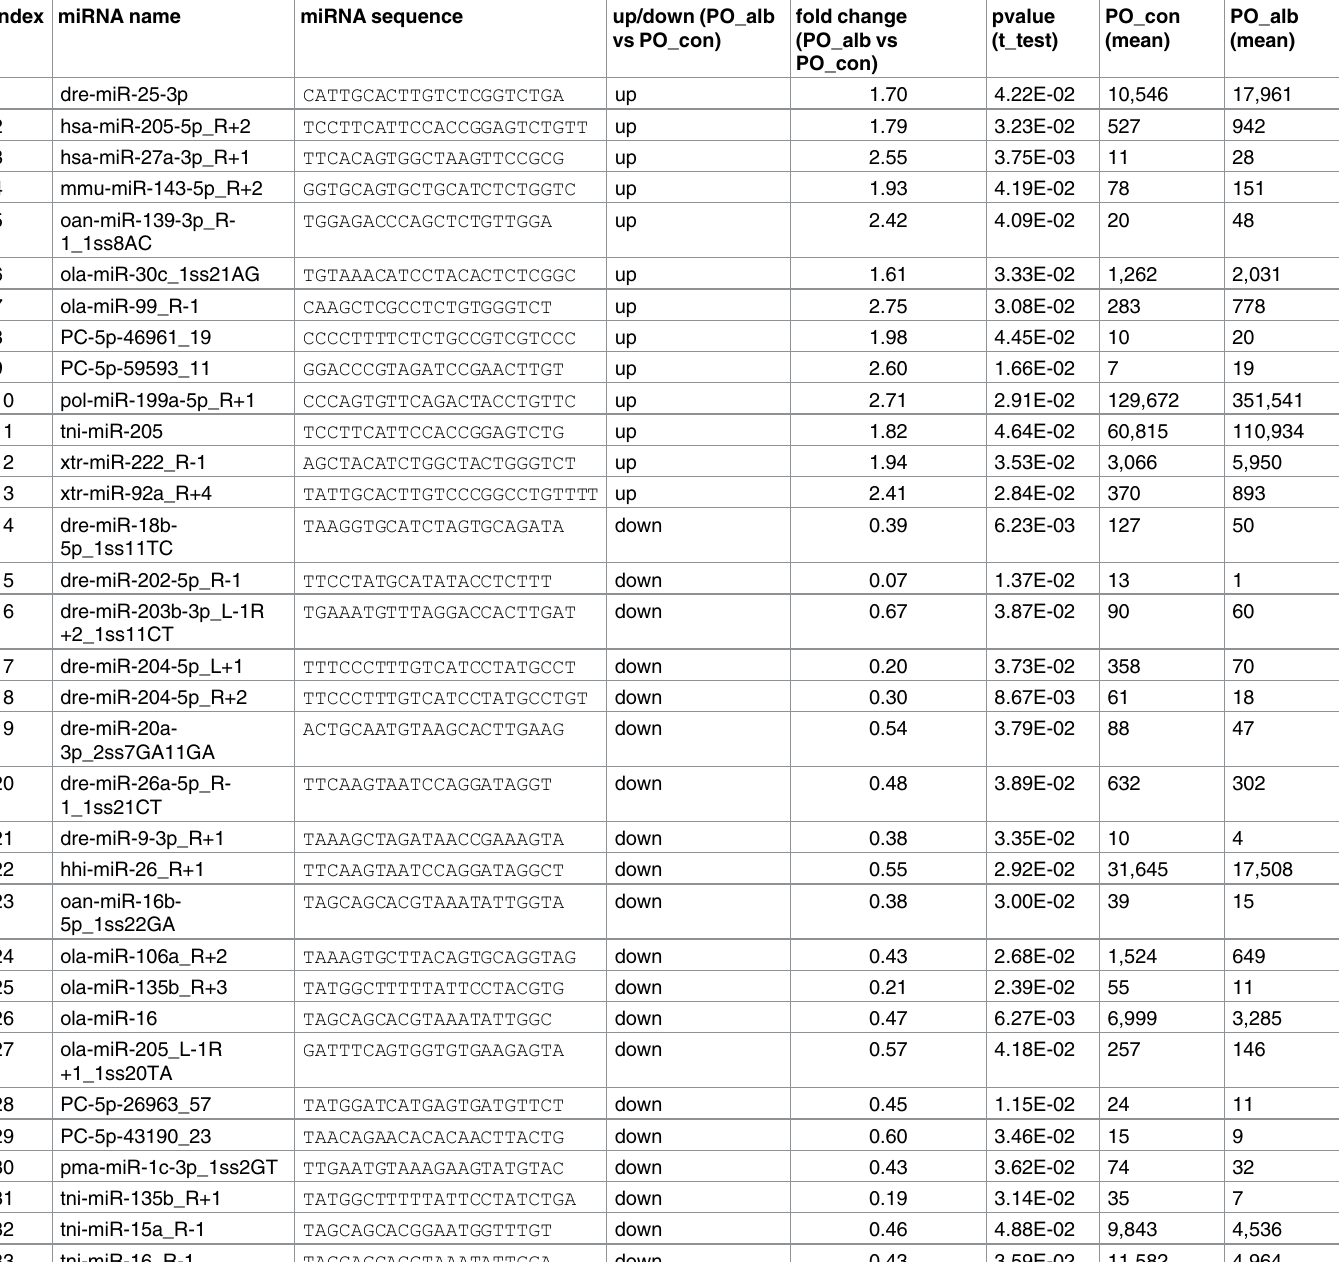
Table 2. Differential expression of miRNAs in albino and normal Japanese flounder (p <